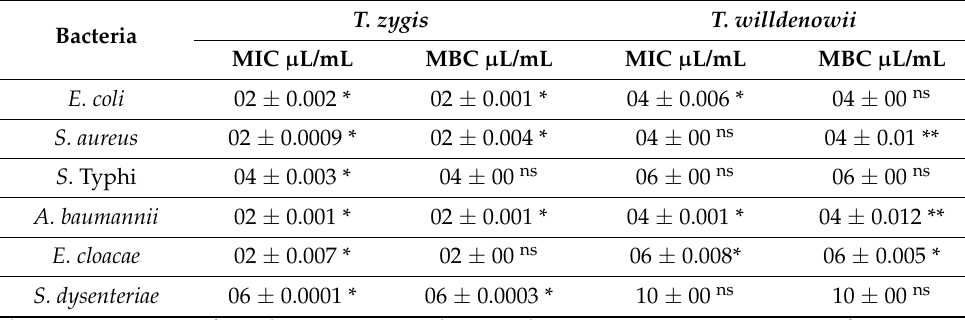
Table 7. Determination of MIC and MBC of T. zygis and T. willdenowii EOs. T. zygis T. willdenowii Bacteria MIC µ L/mL MBC µ L/mL